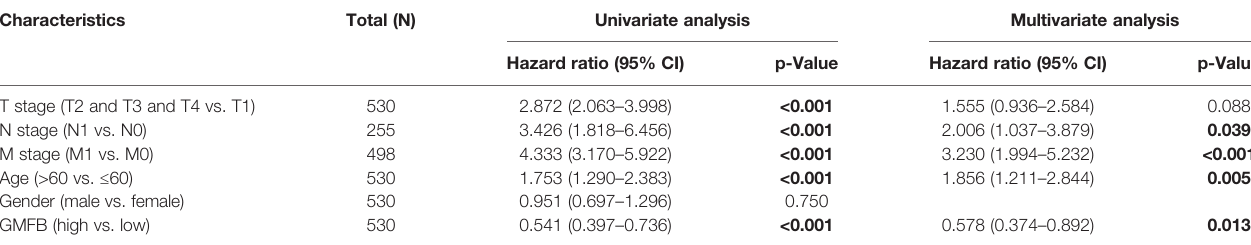
TABLE 3 | Univariate and multivariate Cox proportional hazard analyses of Gmfb expression and overall survival (OS) for patients with KIRC.